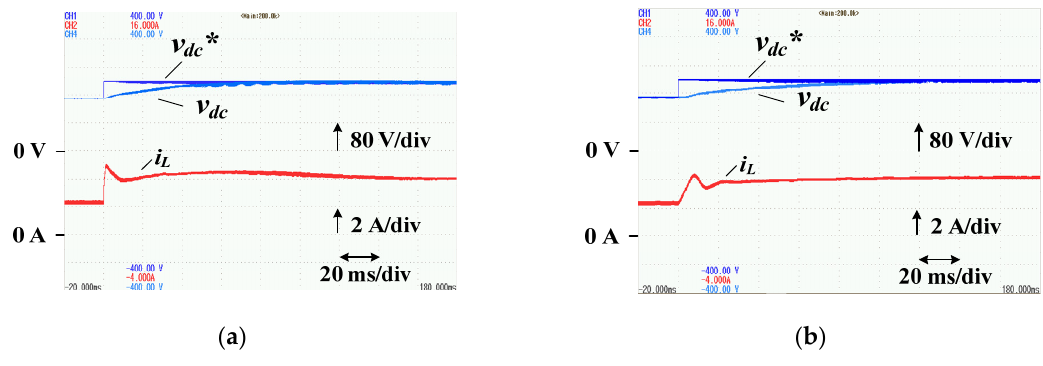
Figure 17. Step response (150 V to 200 V). ( a ) PI control; ( b ) LQR.